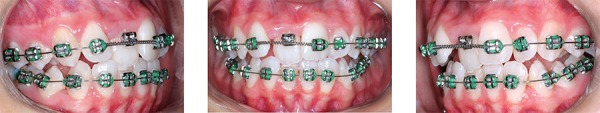
Intraoral photographs 8 months after treatment onset.